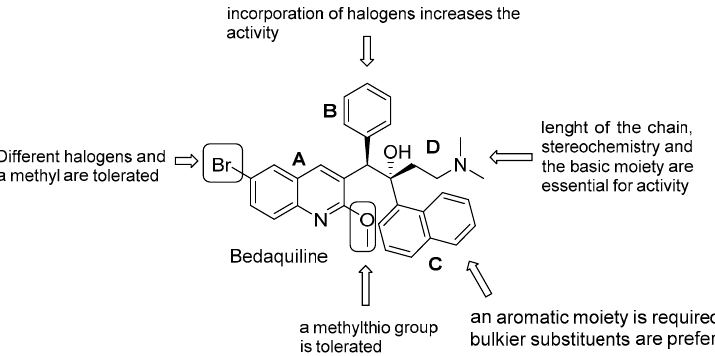
Figure 17. The chemical structure of bedaquiline and SARs of analogues.